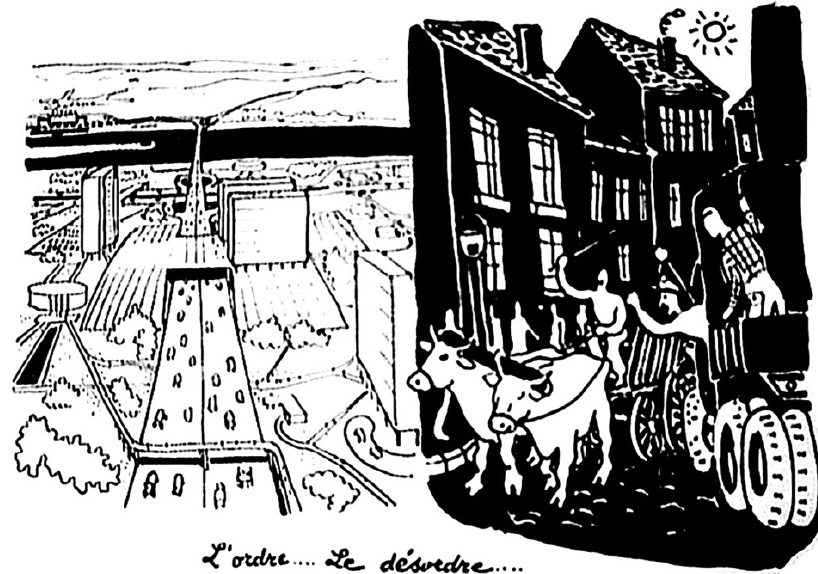
Figure 2. A 1948 drawing by Adolf Bayer shows the striking contrast between the modernist city—’order’—and the tra- ditional city—’disorder.’ The traditional city on the right features a mix of uses and modes on walkable streets, buildings defining the edges of public spaces including streets, a mix of buildings and heritage patterns, and an open, self-organizing pattern shaped by many actors, which only seems chaotic. The modernist city on the left, however, features segregated uses, pedestrians segregated from streets, a loose pattern of buildings floating in green space, pristine buildings, and a highly determined, static environment created by technical specialists. Source: Google Images (‘labelled for reuse’ filter